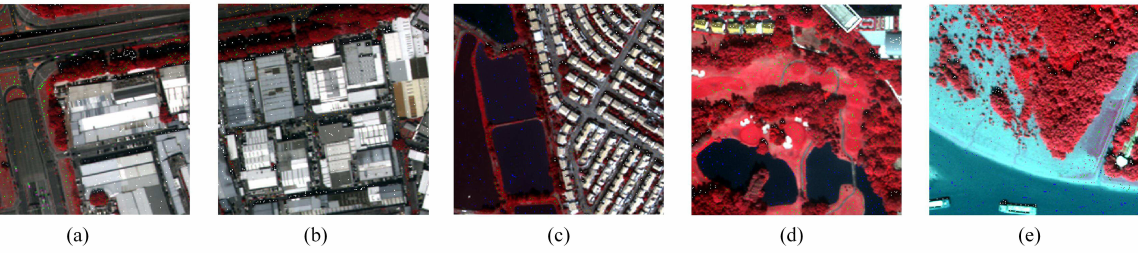
Figure 4. False color composite images with sample points.